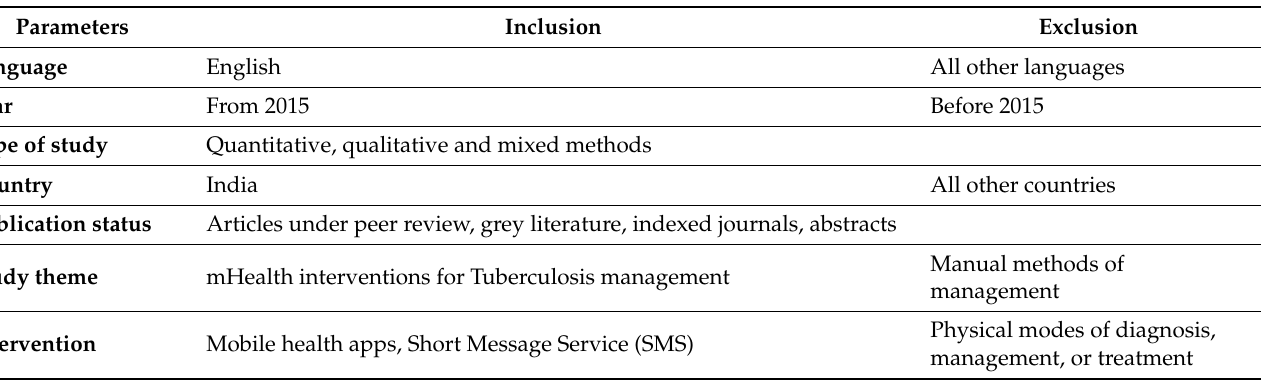
Table 1. Criteria for inclusion and exclusion of articles.